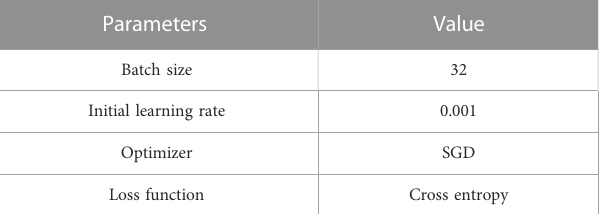
TABLE 1 The parameters used in transfer learning.